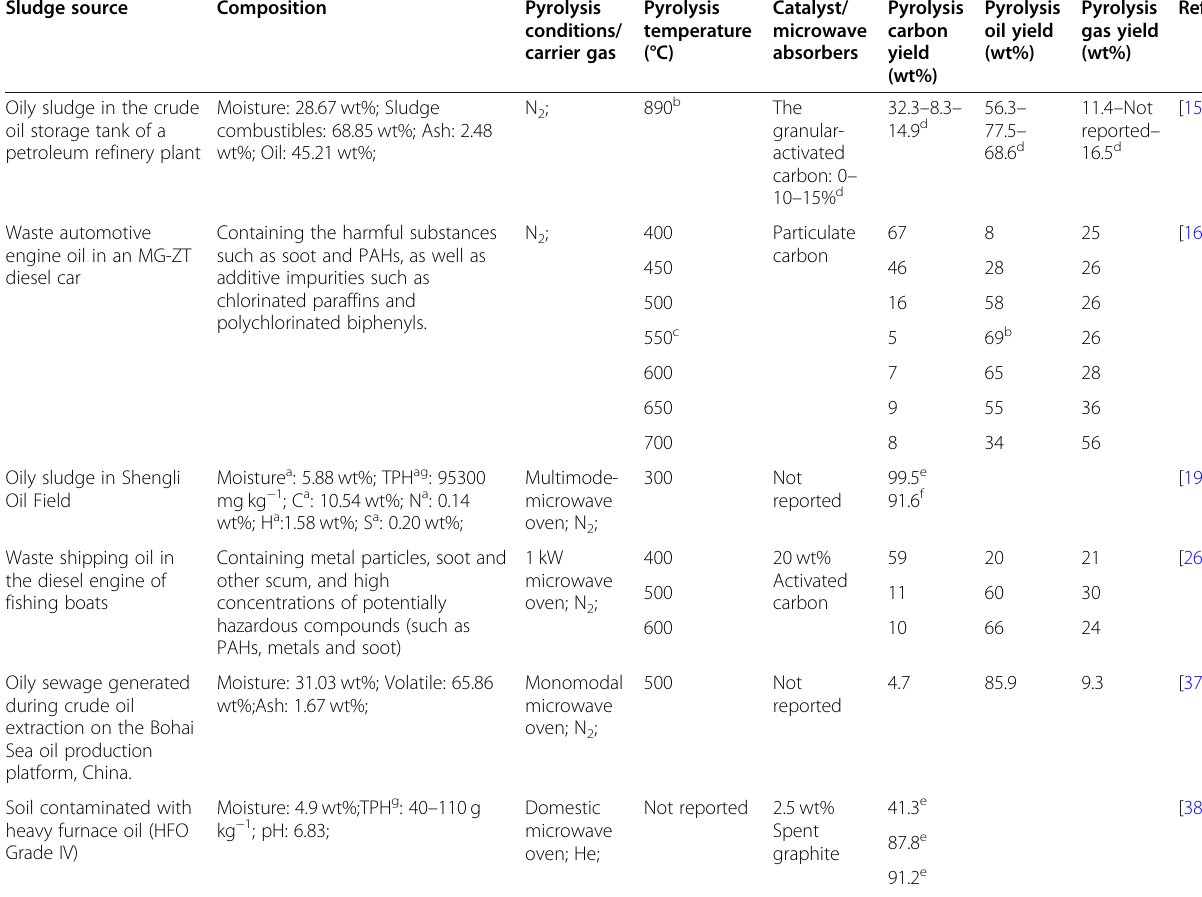
Table 2 The product yield of sludge impurities with different oil content under different microwave pyrolysis conditions Sludge source Composition